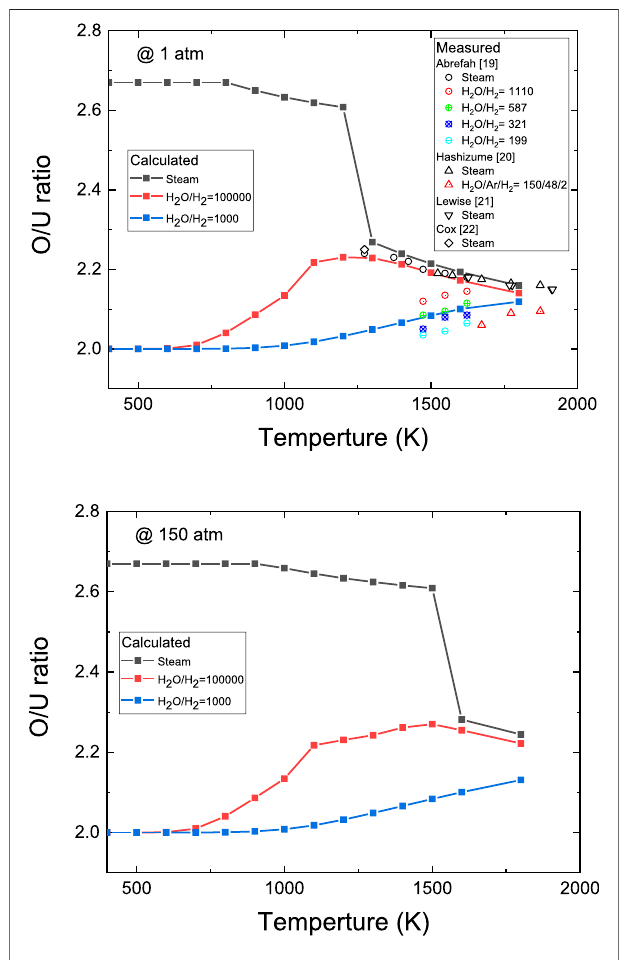
FIGURE5| CalculatedequilibriumO/UratiooftheU – Osystemusingthe equations in Ref (Kim, 2000). and comparison with experimental data.